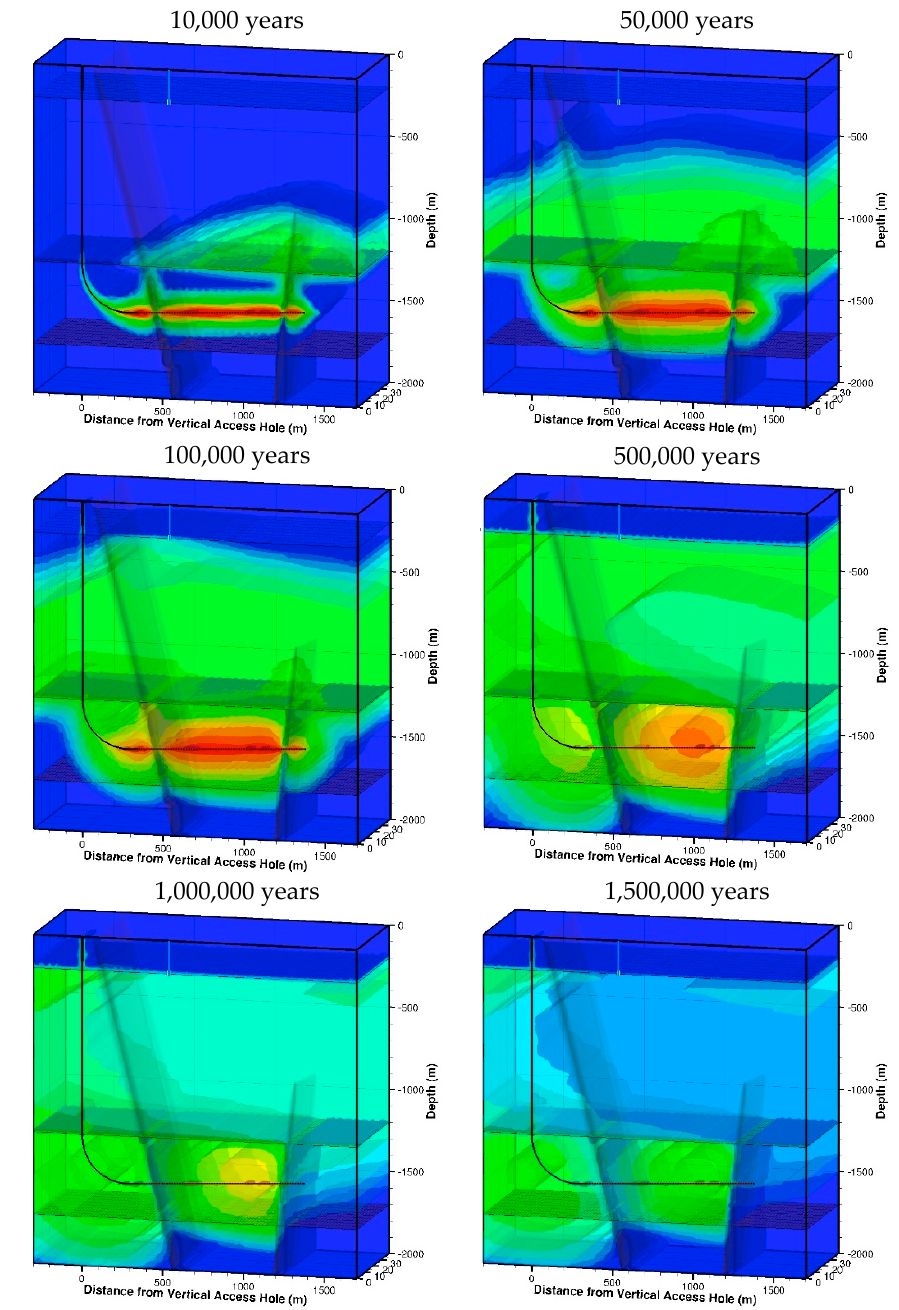
Figure 7. Distribution of 129 I activity at different times for two ‐ fault scenario with poorly ‐ sealing backfill.